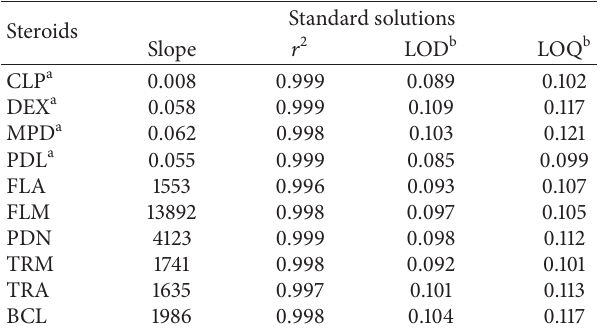
Table 2: Validation data of linearity and LOD and LOQ for samples containing spiked standard solutions in blank cosmetic prepara- tions. a Internal calibration. b Concentration in mgkg −1